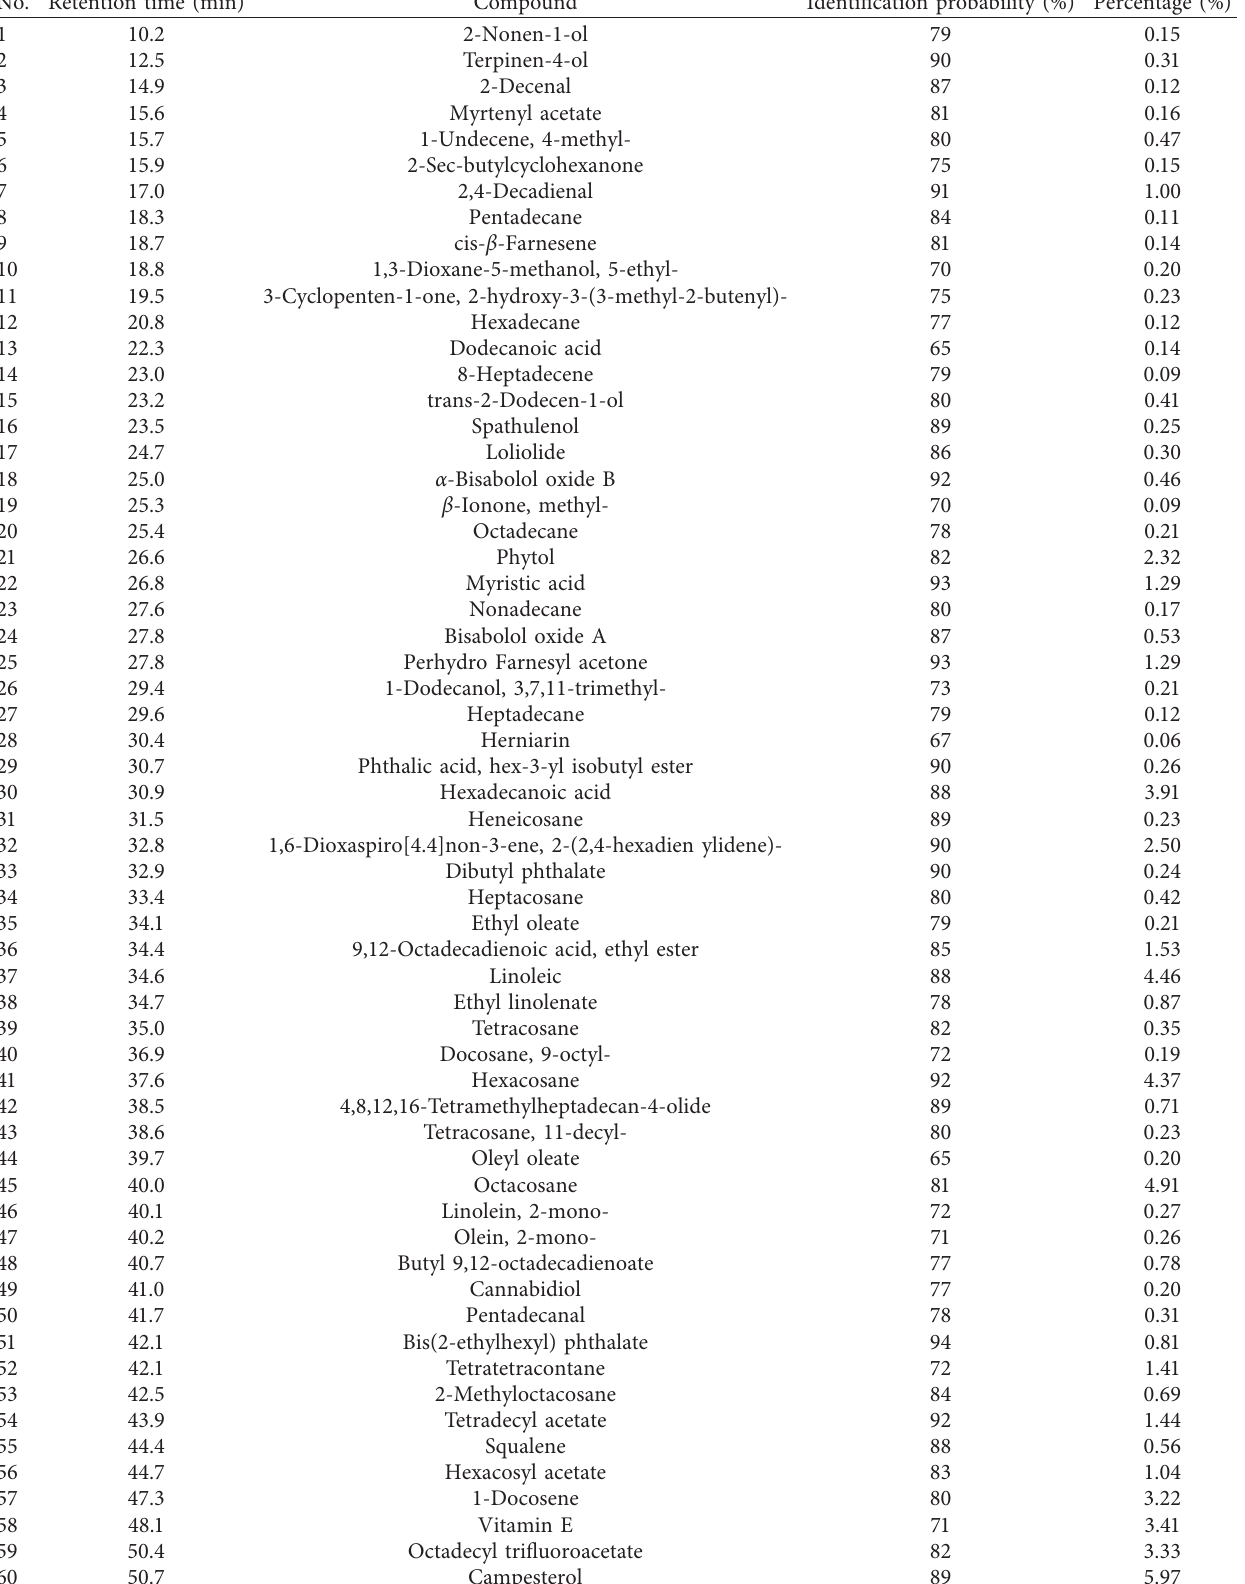
Table 1: The results of chromatographic analysis of Portulaca oleracea ’s CO